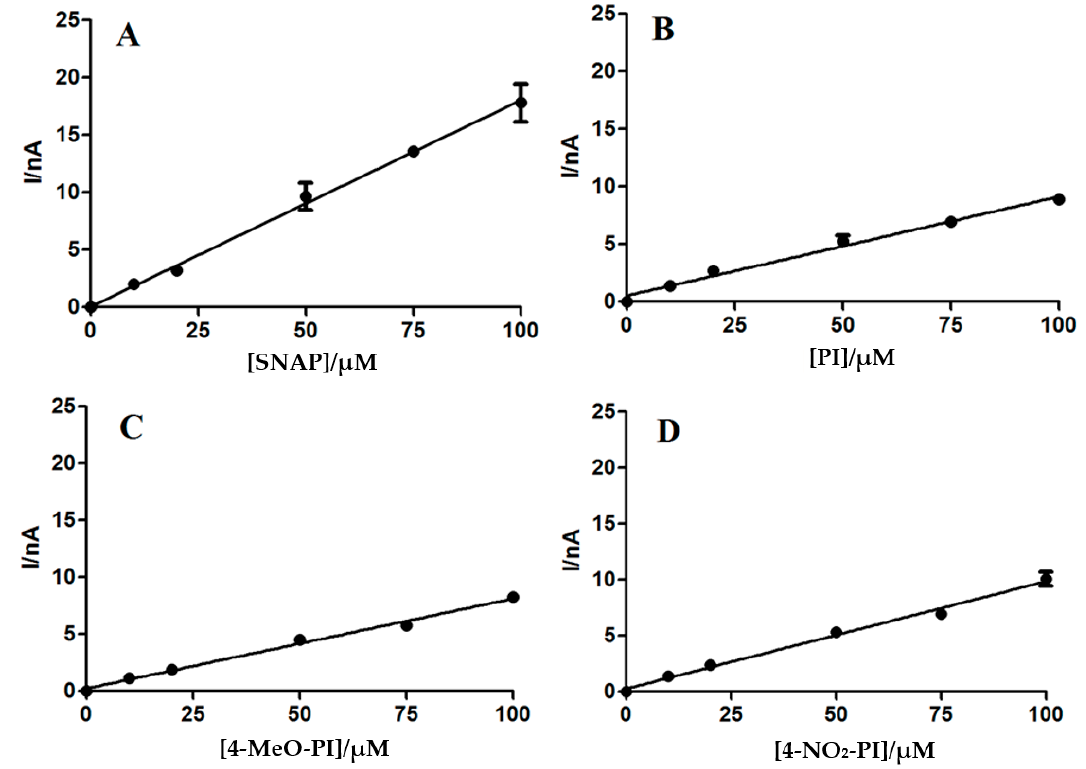
Figure 6. CPAs of SNAP ( A ), PI ( B ), 4-OMe-PI ( C ) and 4-NO 2 -PI ( D ). All experiments were carried out in fresh PBS, in the dark, at 37 ◦ C. Currents were recorded at a fixed potential of +865 mV vs. Ag/AgCl. The concentration range was from 0 to 100 µ M for all NO-donors. Table 1. In Vitro NO calibration parameters (slope ± SEM and R 2 ) obtained from NO-donor molecules on OPD/Nafion ® (The Chemours Company FC, LLC) modified epoxy carbon electrodes a .